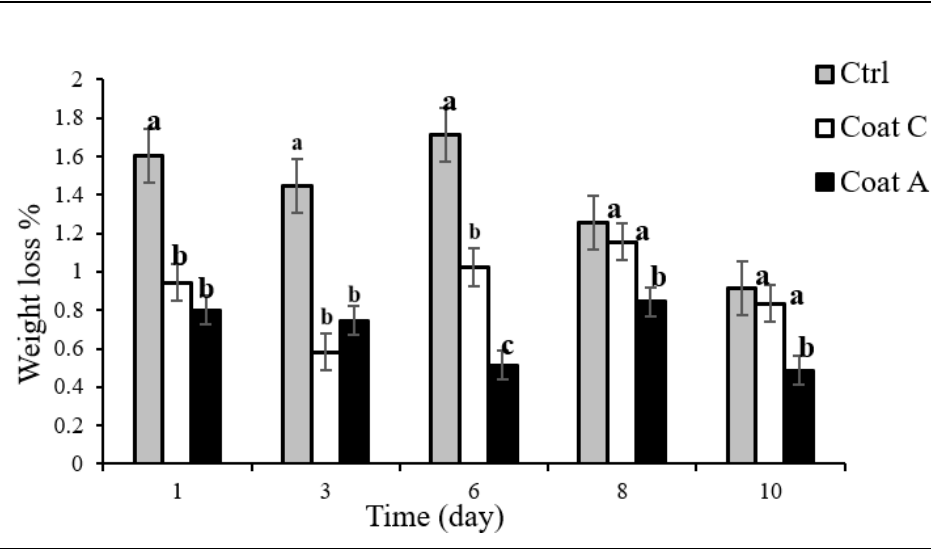
Figure 1. Weight loss (%) of prickly pears during storage at 4 ◦ C. a,b,c Different superscript letters indicate that means are significantly different ( p < 0.05). Ctrl = sample without coating; Coat C = sample with alginate coating; Coat A = sample with alginate and